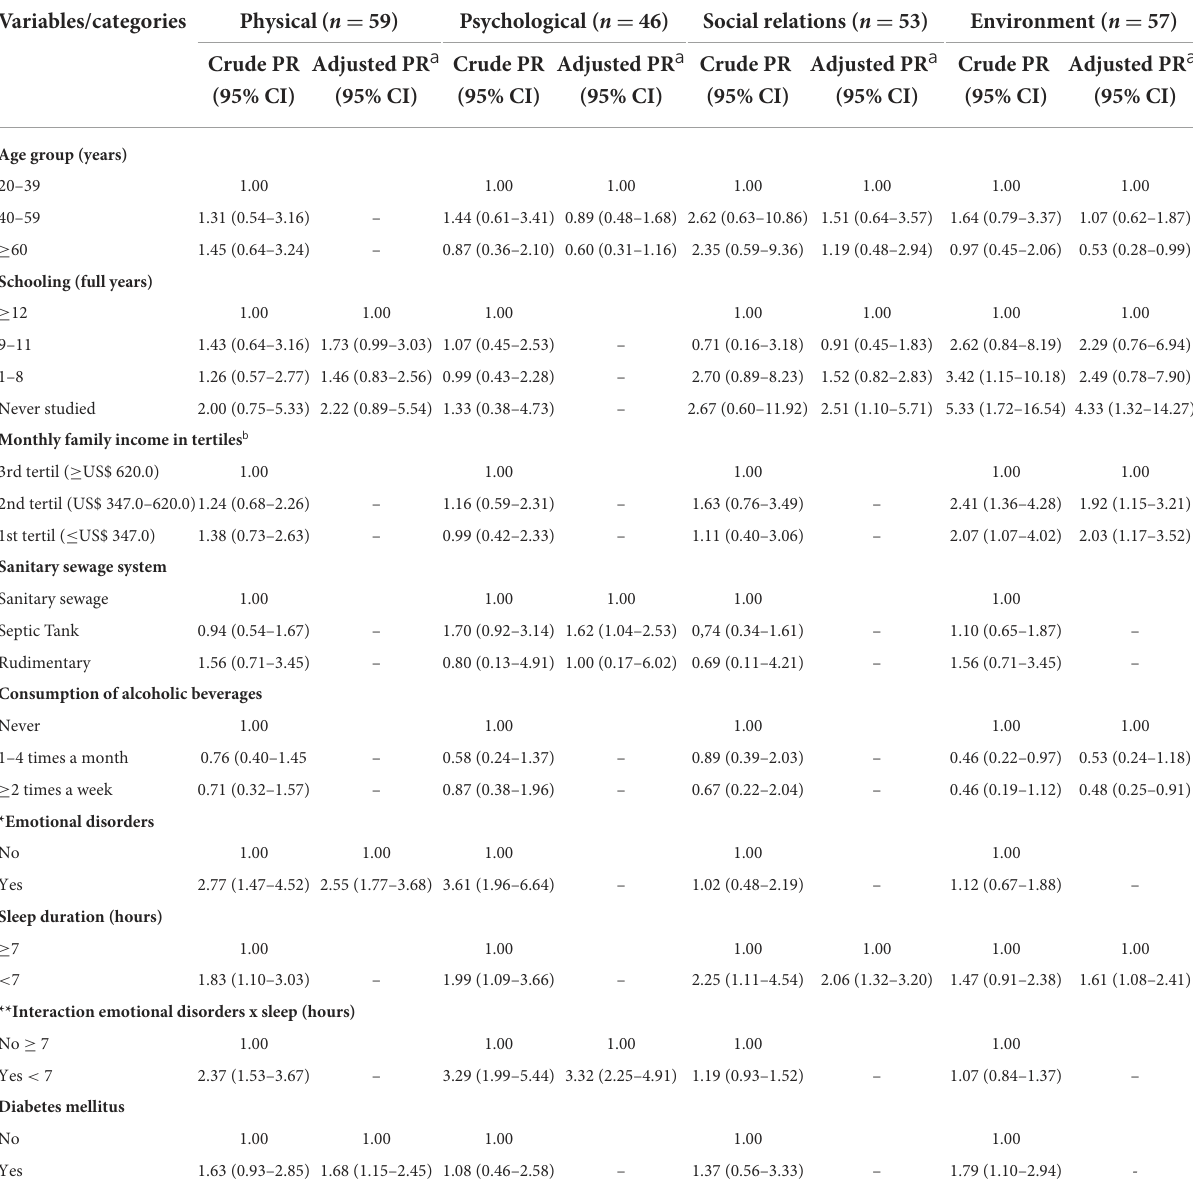
TABLE 2 Crude and adjusted Prevalence Ratios (PR) and Confidence Intervals (95%) of the variables associated with low perceived quality of life * (LPQoL) in the physical, psychological, social relations and environment domains of adults and older adults with Food Security (FS).